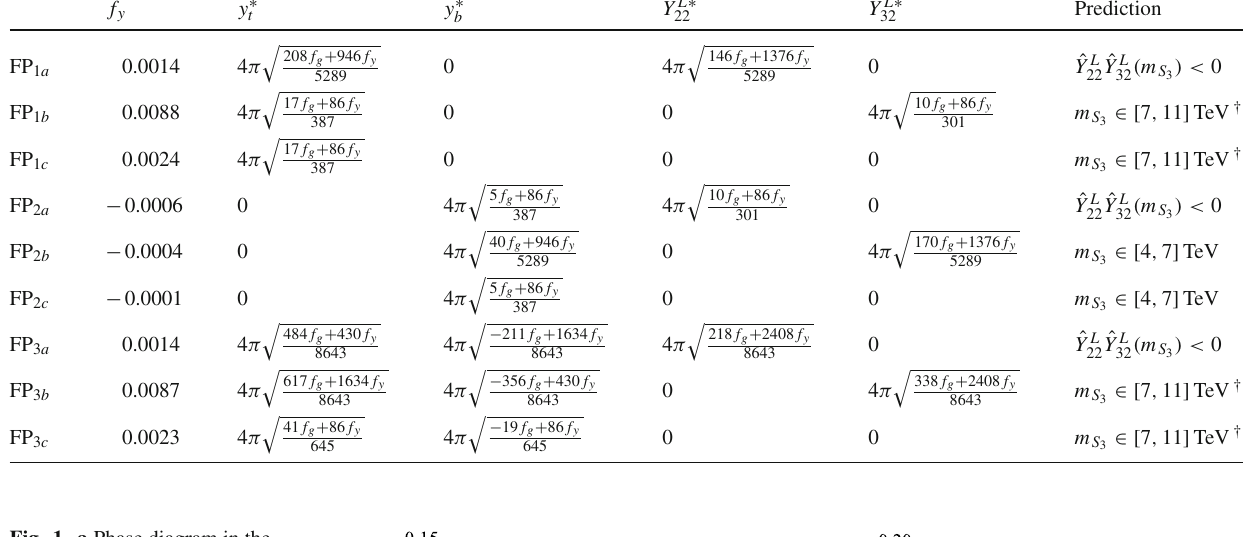
Fig. 1 a Phase diagram in the plane ( V 33 , ˆ Y L ) in the vicinity 32 of the UV fixed point FP 1 a , indicated here as a red dot. All the remaining couplings are set to their fixed-point values. The RG flow directions point towards the UV. Only the RG trajectories marked in red allow one to reach the UV fixed